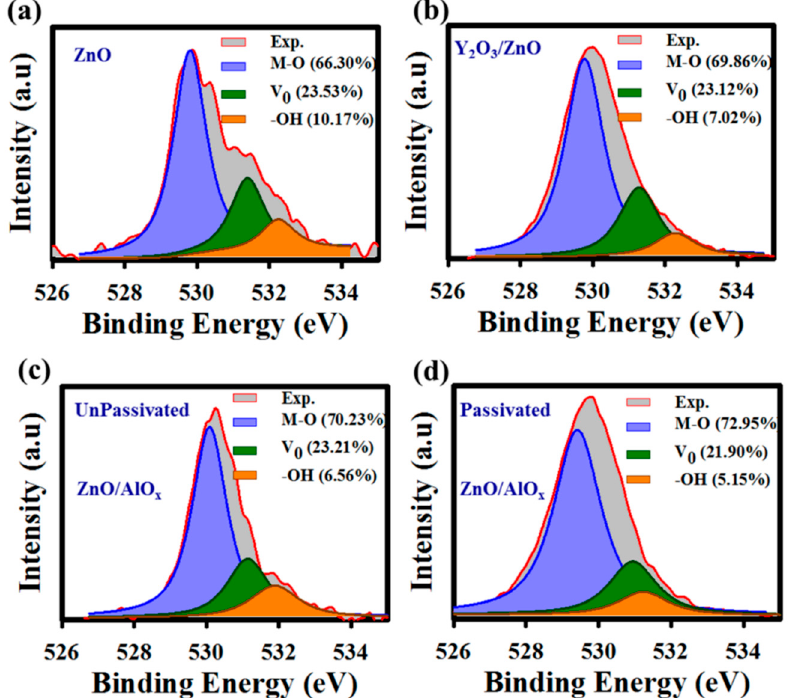
Figure 3. XPS spectra analysis of the deconvoluted O 1s peak ( a ) in the bulk of ZnO and ( b ) at the interface of Y 2 O 3 / ZnO. Deconvoluted O 1s peak at the interface of ZnO / Al 2 O 3 ( c ) without and ( d ) with Y 2 O 3 passivation. The individual contribution of metal oxide (M–O), oxygen vacancy (Vo) and metal hydroxyl group (M–OH) are shown by area under the blue line (~529.5 eV), green line (~531 eV), and orange line (~532 eV), respectively. After Y 2 O 3 passivation the Vo and –OH concentrations are reduced at the interface of Y 2 O 3 / ZnO as well as interface of ZnO / Al 2 O 3 .